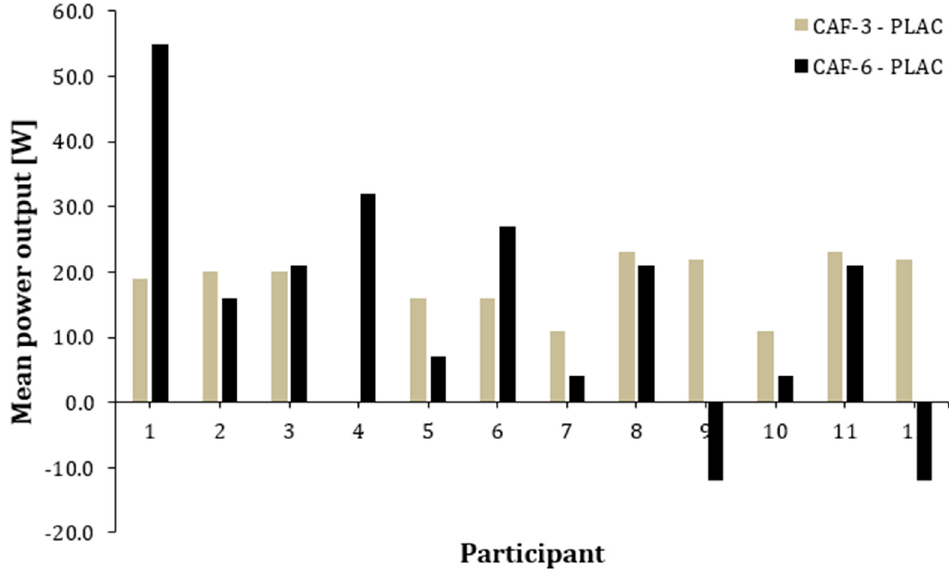
Figure 2. Individual differences in mean power output during 5 sets of bench press throw (BPT) between caffeine and placebo conditions.